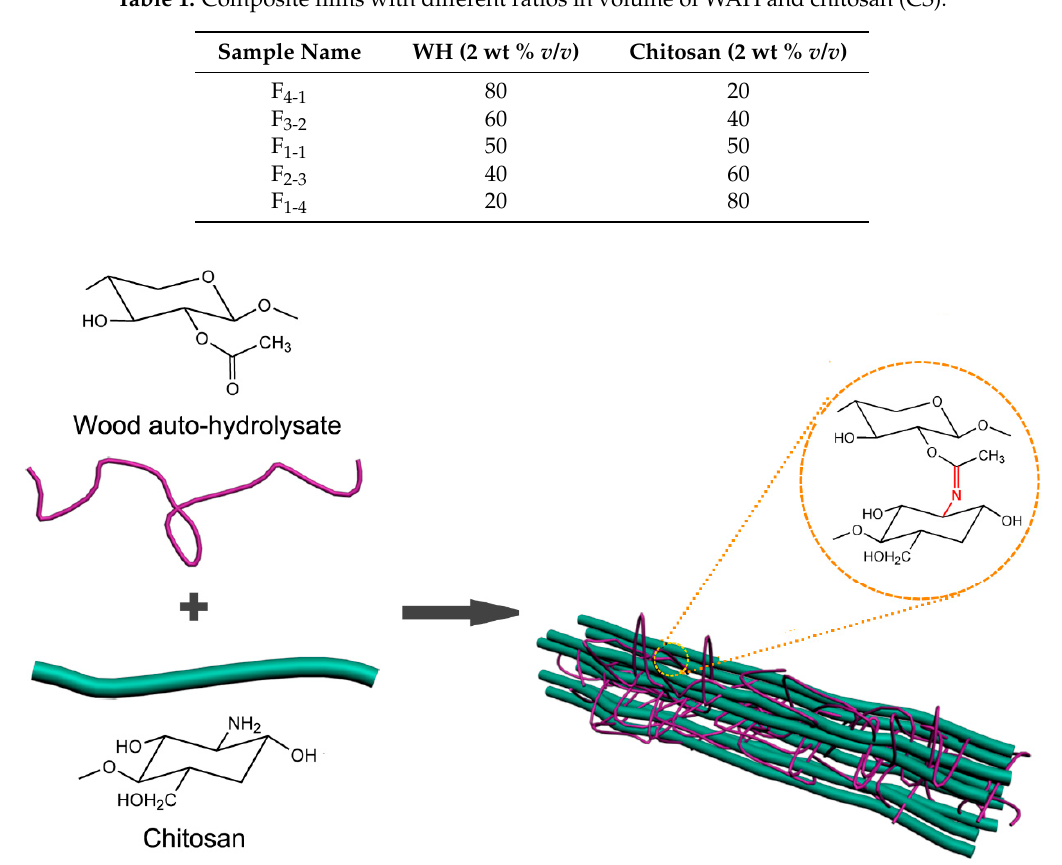
Table 1. Composite films with different ratios in volume of WAH and chitosan (CS).